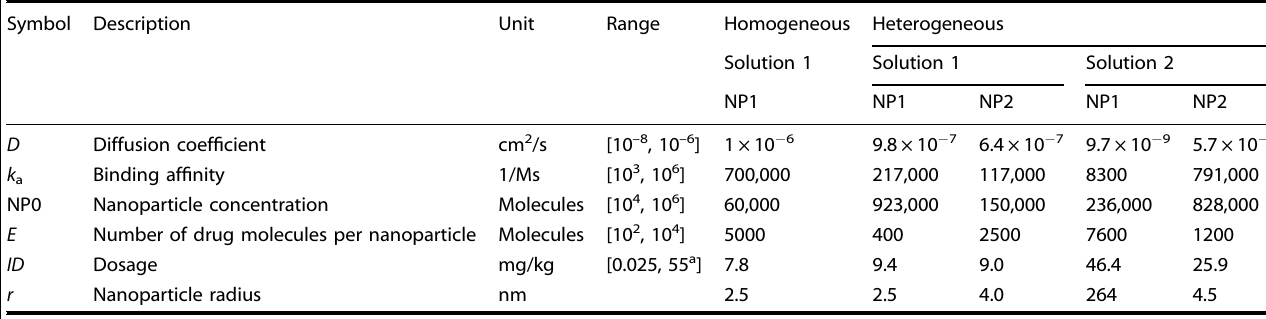
Table 2. Description and values of optimum nanoparticle treatment